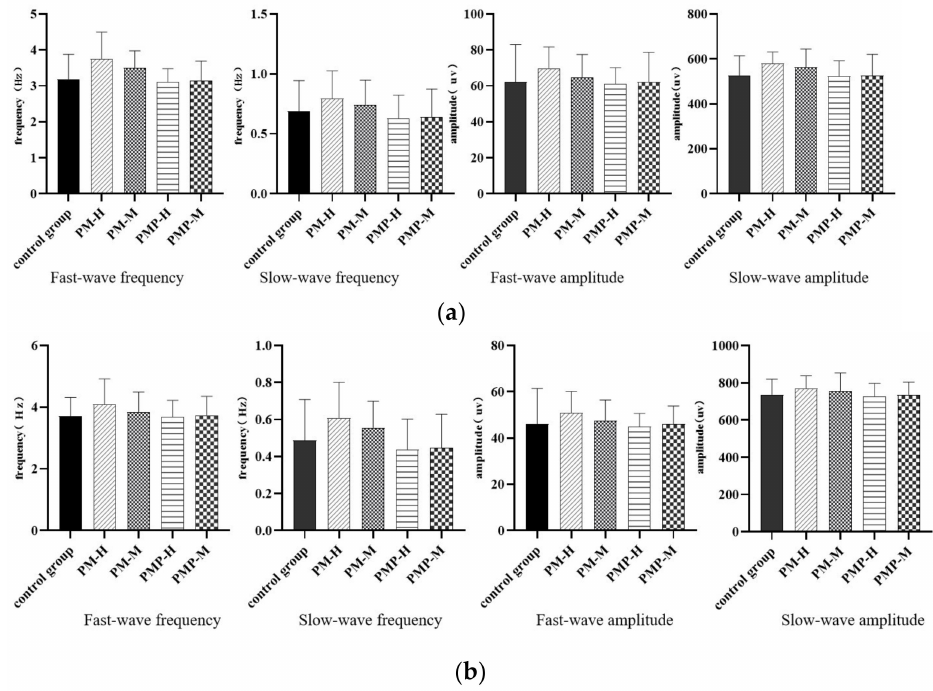
Figure 5. Gastrointestinal myoelectricity after administration: stomach ( a ) and duodenum ( b ). Compared with the control group, after drug withdrawal, PM still had an enhanced effect on gastrointestinal electrical frequency and amplitude, although this was not sig- nificantly different. PMP had no significant impact on gastrointestinal electromyogra- phy (Figure 6), The gastrointestinal myoelectricity after drug withdrawal are shown in Supplementary Materials, Figure S2. Compared with the amplitude and frequency of gas- trointestinal electromyography during drug administration, the frequency and amplitude of gastrointestinal electromyography in the PM group decreased after drug withdrawal, thus suggesting that the effect of PM on the gastrointestinal tract can gradually recover to normality after drug